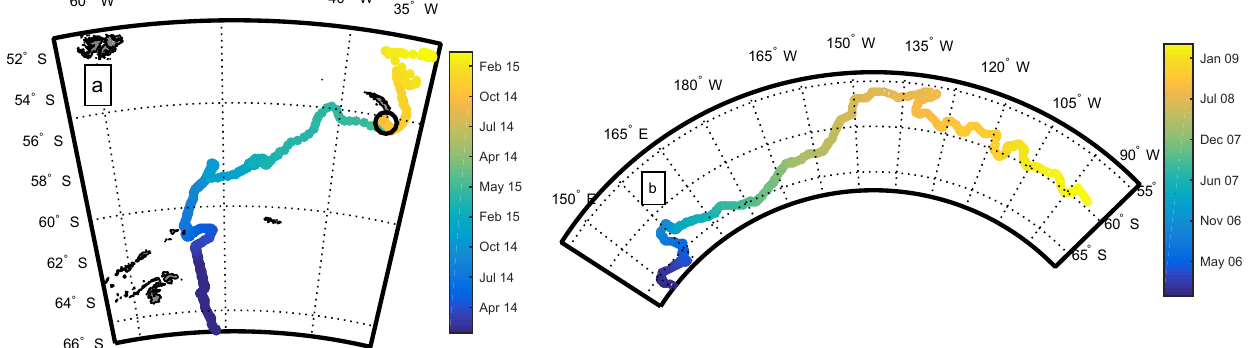
Figure 1. Trajectories of B17a (a) and C19a (b) icebergs. The black circle locates the B17a grounding site. The colour scale represents the time along the